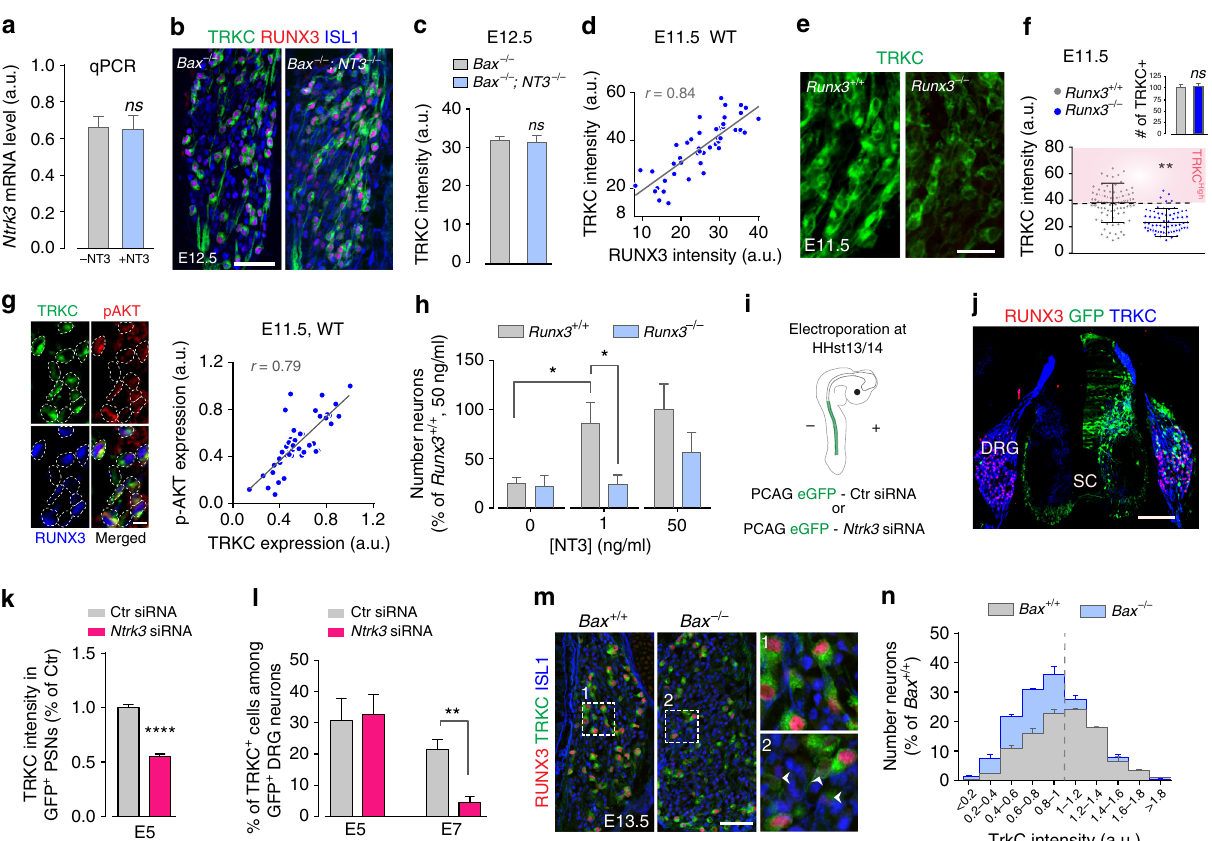
Fig. 2 Regulation of TRKC levels in PSNs and their correlation with differential survival. a Quanti fi cation of Ntrk3 in E11.5 DRG cultured for 6 h with or without NT3 (50 ng/ml) ( n = 4). b TRKC/RUNX3 immunostaining on E12.5 DRG sections from Bax − / − and Bax − / − ; NT3 − / − animals 34 . Scale bar: 50 μ m. c Quanti fi cation of TRKC levels in individual PSNs from E12.5 Bax − / − and Bax − / − ; NT3 − / − animals in b ( n = 2), with similar number of PSNs in both Bax − / − and Bax − / − ; NT3 − / − DRG ( P = 0.83, unpaired Student ’ s t -test). d Correlation between RUNX3 and TRKC levels in individual E11.5 PSNs. e TRKC expression in E11.5 DRG sections from Runx3 + / + and Runx3 − / − animals. Scale bar: 20 μ m. f Quanti fi cation of TRKC intensity in individual PSNs in E11.5 Runx3 + / + and Runx3 − / − animals. ** P < 0.01. Bar graph: number of TRKC + neurons in E11.5 Runx3 + / + and Runx3 − / − animals; ns, not signi fi cant, unpaired Student ’ s t -test ( n = 3). g Immunostaining for TRKC, RUNX3 and p-AKT on E11.5 DRG sections and quanti fi ed correlation between TRKC and p-AKT levels in individual PSNs (right panel). h Survival of E11.5 DRG neurons from Runx3 + / + and Runx3 − / − animals treated with NT3 for 48 h (* P < 0.05, n = 4 – 6, one-way analysis of variance (ANOVA) with Sidak ’ s multiple comparisons test). i Scheme representing the in ovo electroporation (HHst 13/14, or E2). j Cross section of electroporated HHst26/27 embryos (E5) showing transfected cells in half spinal cord (SC) and in the ipsilateral DRG. k Quanti fi cation at E5 (before cell death period) of TRKC intensity among transfected PSNs (RUNX3 + /TRKC + ). **** P < 0.0001, unpaired Student ’ s t -test. l Comparison before (E5) and after cell death period (E7) of the % of PSNs in transfected GFP + neurons. ** P < 0.01, unpaired Student ’ s t -test ( n = 4). m TRKC and RUNX3 expression in PSNs of E13.5 Bax + / + and Bax − / − DRG sections. (Right) Boxed regions (1) and (2) are magni fi ed. Arrowheads show PSNs with lower size (see Supplementary Fig. 6c). Scale bar: 50 μ m. n Quanti fi cation of TRKC levels in PSNs from E13.5 Bax + / + and Bax − / − DRG neurons ( n = 4). Dashed line distinguishes TRKC High and TRKC Low populations. Source data are available as a Source Data fi